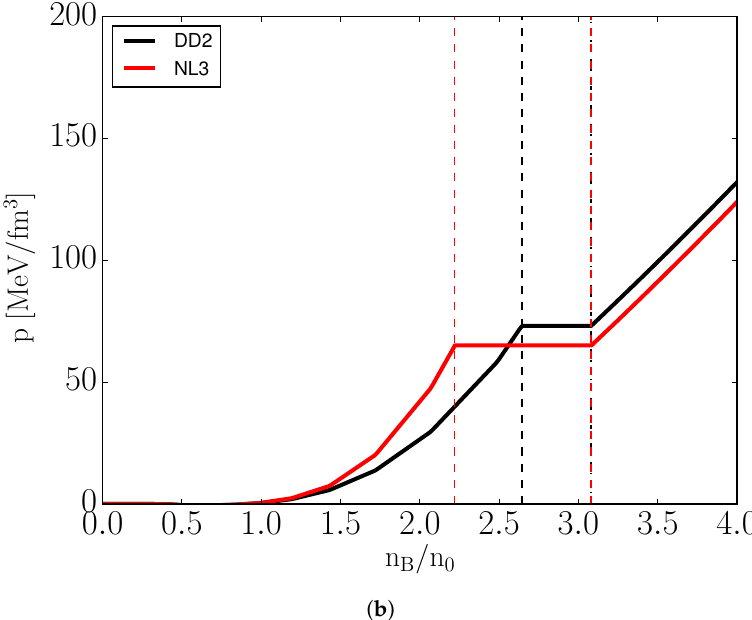
Figure 1. Pressure as a function of energy density ( a ) and baryon density ( b ) for cold isospin symmetric matter ( µ C = 0) modeled using vBag ( B 1/4 χ = 152.7 MeV, K v = 6 hadronic EoS. Dashed lines highlight mixed phase regions.